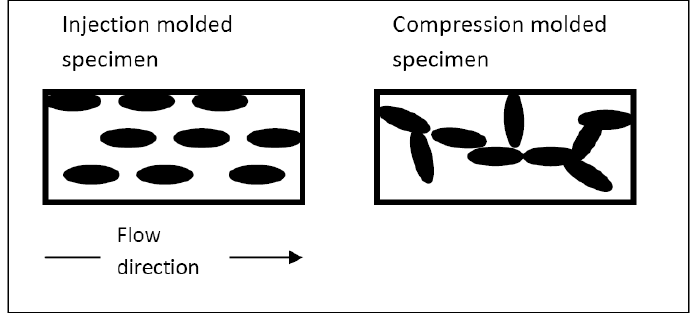
Figure 4. Schematic representation of filler distribution in the polymer matrix: (a) filler orientation along the flow direction in injection-molded specimen, and (b) random filler orientation in a compression-molded